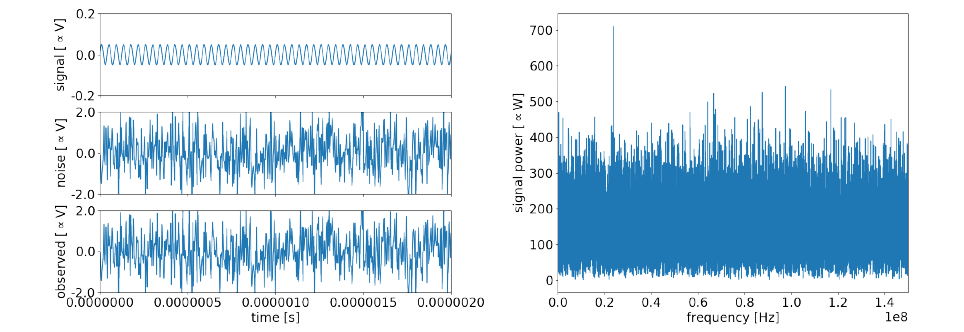
Figure 2. A simplified version of CRES signal extraction for Project 8. On the left all panels are shown in the time domain, the top panel shows a simple sine-like signal with amplitude much smaller than the uniform noise shown in the middle. The bottom panel shows the combination of the two, which is by eye is indistinguishable from the noise alone. On the right, a Fourier transform has been used to move into the frequency domain, where is the original signal is clearly visible above the